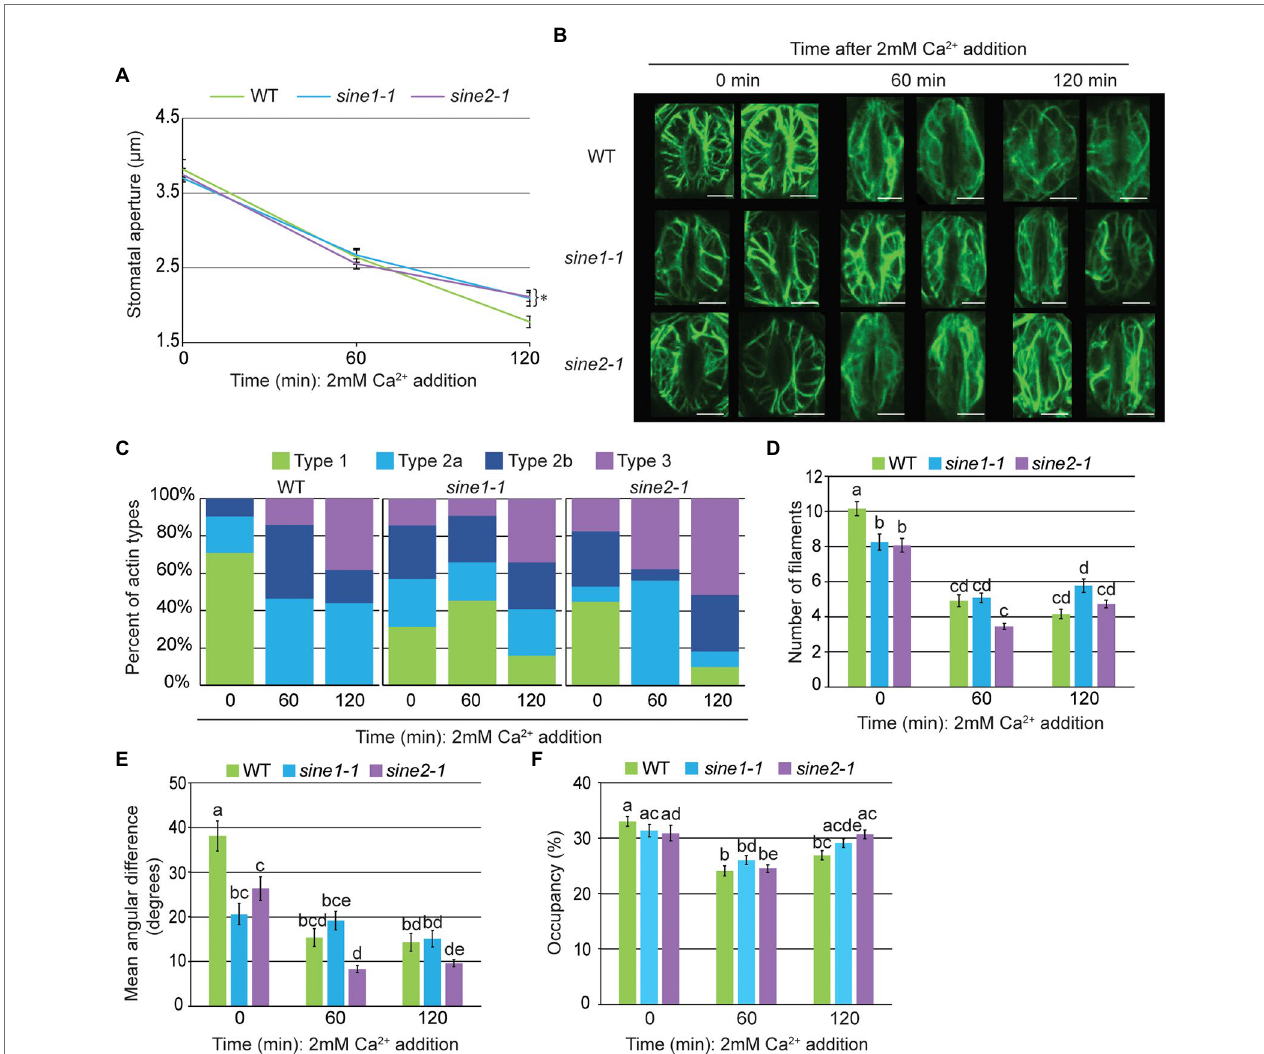
FIGURE 3 | Calcium-induced stomatal closure partially restores actin organization defects observed in sine mutants. (A) Stomatal aperture measurements in GFP- LIFEACT transgenic lines at 0, 60, and 120 min after addition of 2 mM Ca 2+ . Data are mean values ± SE from three independent experiments ( N ≥ 24 stomata). Symbols denote statistically significant difference to WT as determined by Student’s t -test, with * p < 0.05. (B) Representative maximal intensity projections of actin organization at 0, 60, and 120 min after addition of 2 mM Ca 2+ . Scale bars = 5 μ m. (C) Distribution of actin types at 0, 60, and 120 min after ABA addition. (D) Actin filament numbers in WT, sine1-1 , and sine2-1 guard cells. (E) The mean angular difference of actin filaments. (F) Occupancy (density) of actin filaments in WT, sine1- 1 , and sine2-1 . (D–F) Data are mean values ± SE from three independent experiments ( N ≥ 44 guard cells). Statistical significance was calculated using